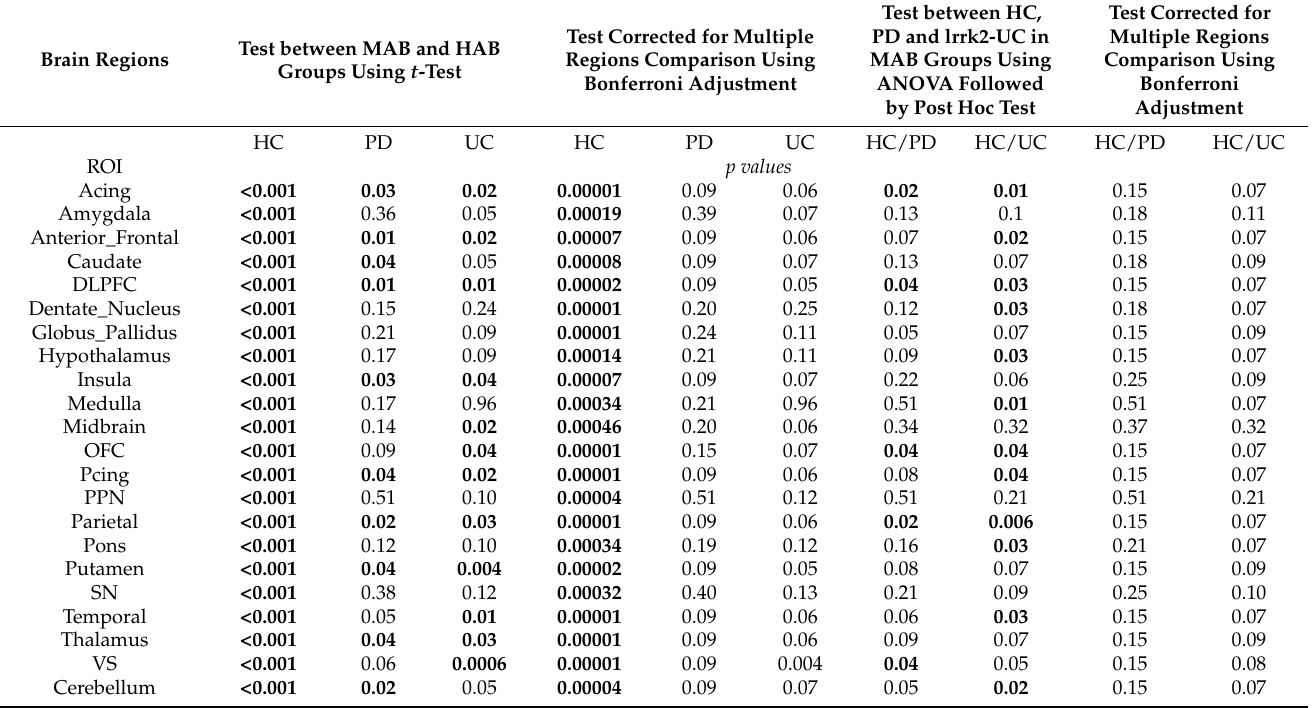
Table 2. Statistics